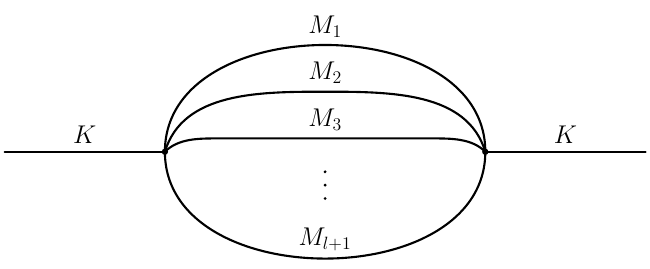
Figure 1 . The l-loop banana